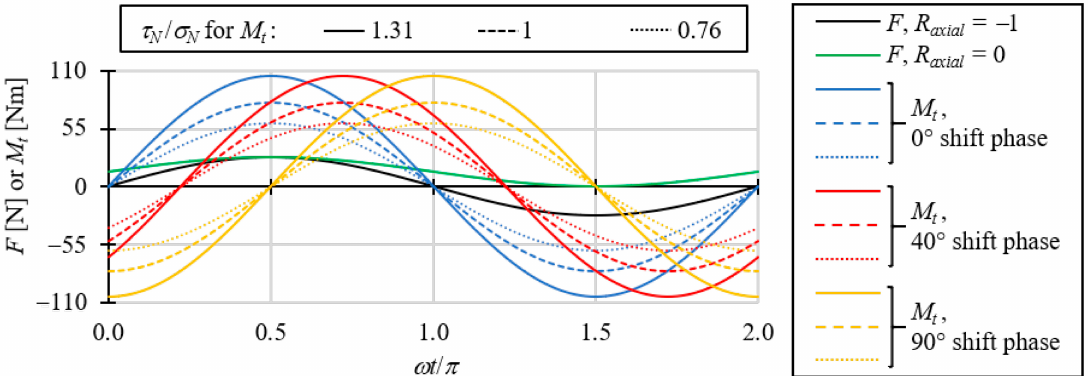
Figure 2. Load-time curves used for the experimental investigation